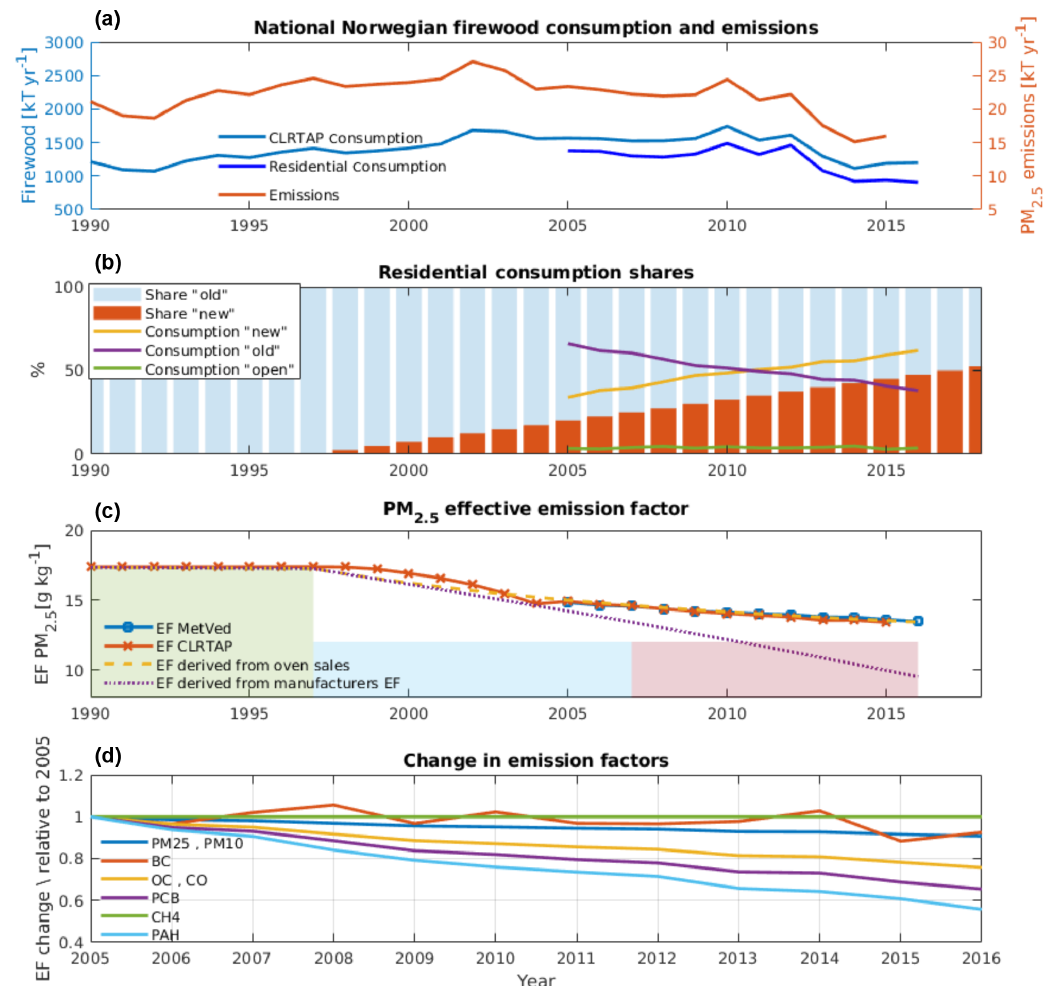
Figure 4. (a) Historical evolution of the officially reported consumption of firewood and emissions of PM 2 . 5 since 1990. (b) Consumption per technology class for new, old and open in yellow, blue and green, respectively. Red bars show the stock of new ovens assuming a constant sale over time. (c) The coloured bars show the EF of ovens sold in a given year. EF MetVed (blue) is the emission factor used in the MetVed model. EF CLRTAP is derived from officially reported emission and consumption numbers. The yellow dashed line shows the emission factor one would get from the assumed oven sales (red bars in panel a ) and equal consumption in all ovens. The deviating dotted dark blue line shows the derived annual emission factor when manufacturer information on emission factors is used for each year. (d) Annual average emission factors for each year of each component in the MetVed emissions, based on consumption